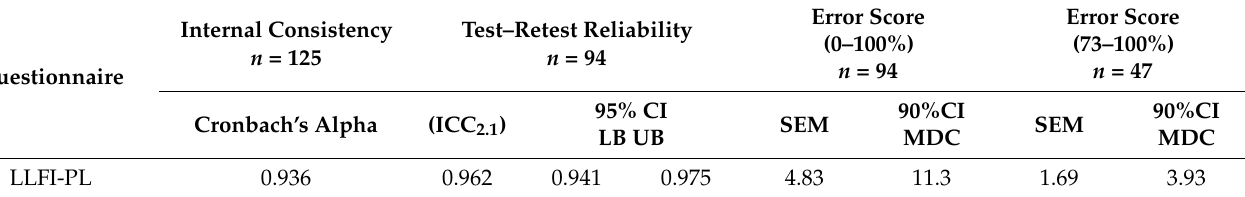
Table 3. Psychometric properties of the LLFI-PL.